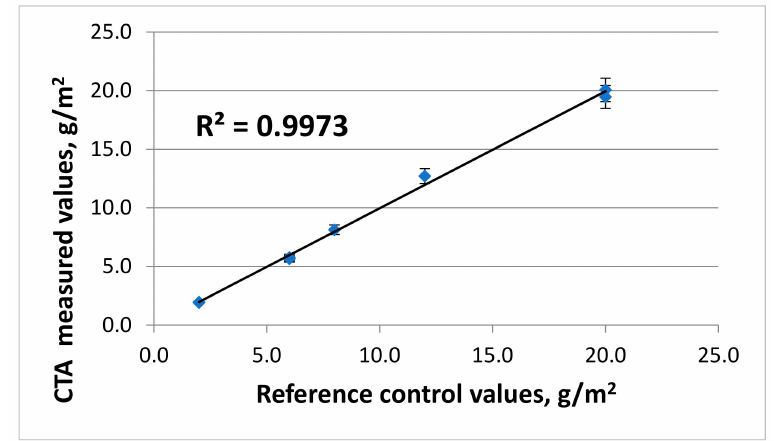
Figure 5. FAT cross-check of CTA measurements compared with control reference